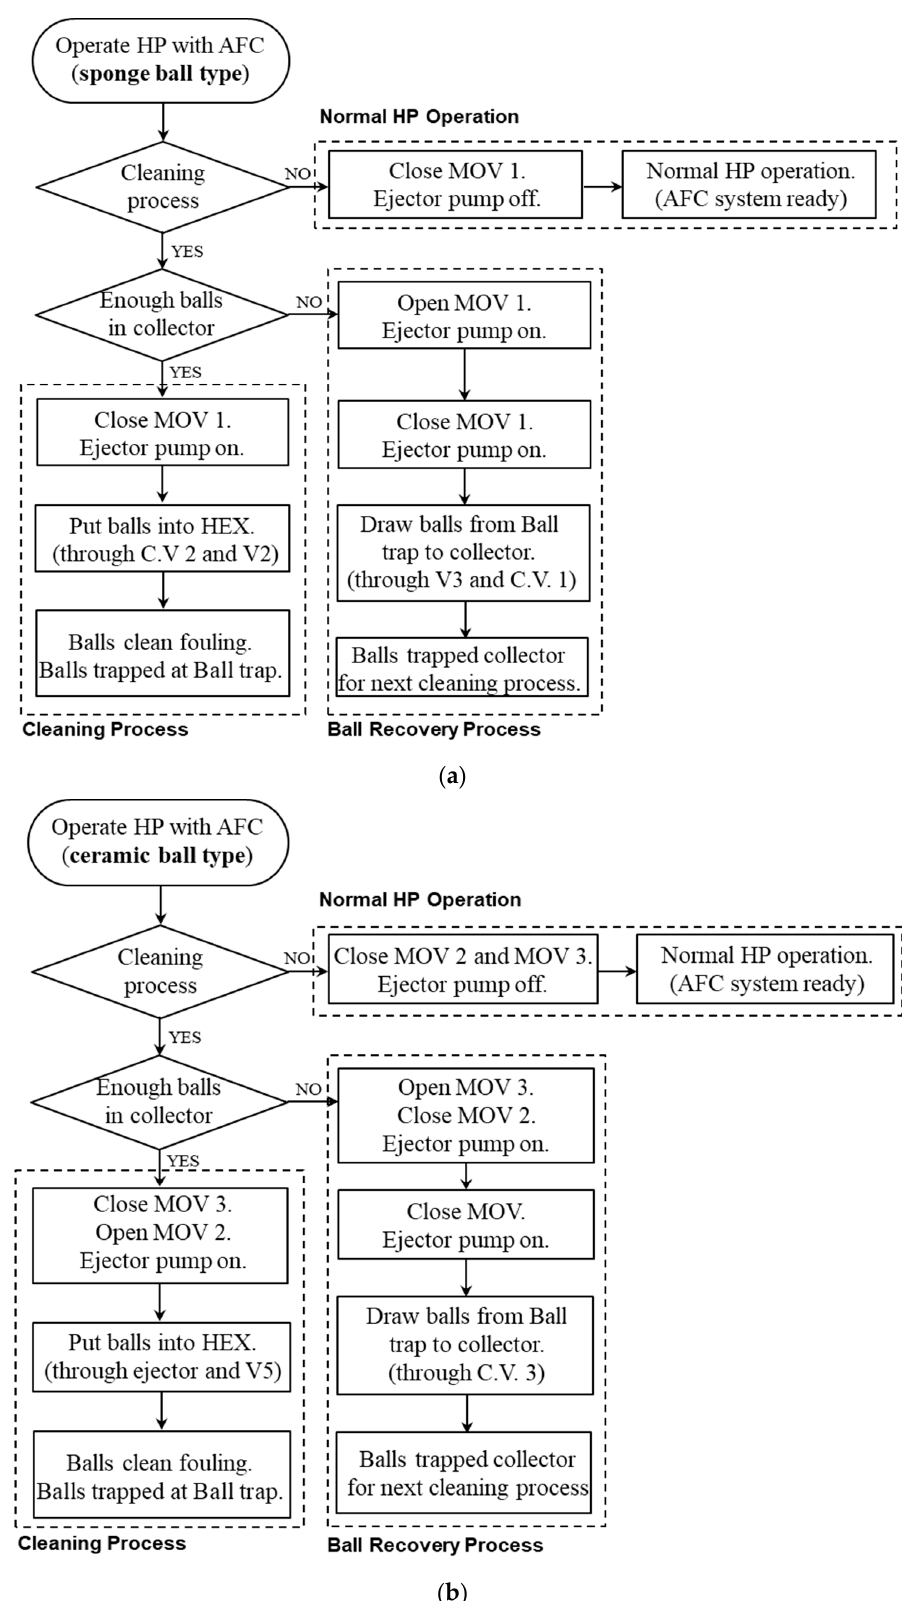
Figure 3. ( a ) Flow chart of operation mechanism of automatic cleaning systems: finned type tube. ( b ) Flow chart of operation mechanism of automatic cleaning systems: twisted type tube.